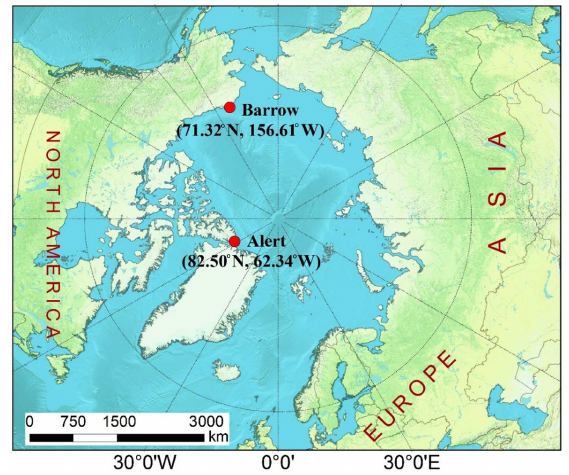
Figure 1. Two receptor sites (Barrow and Alert) in the Arctic. The map was created by ArcGIS